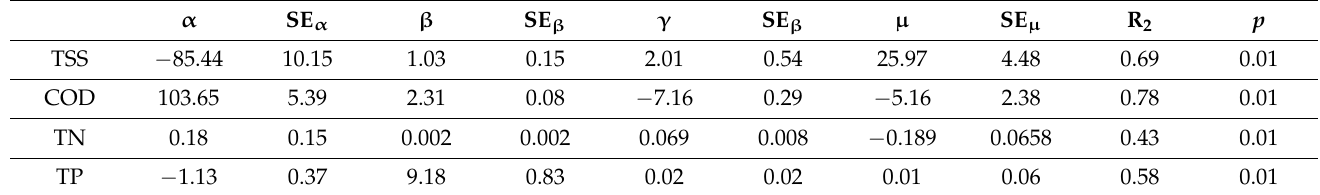
Table 6. Multiple linear regression model of inflow stormwater pollutants’ concentrations considering air quality and rainfall